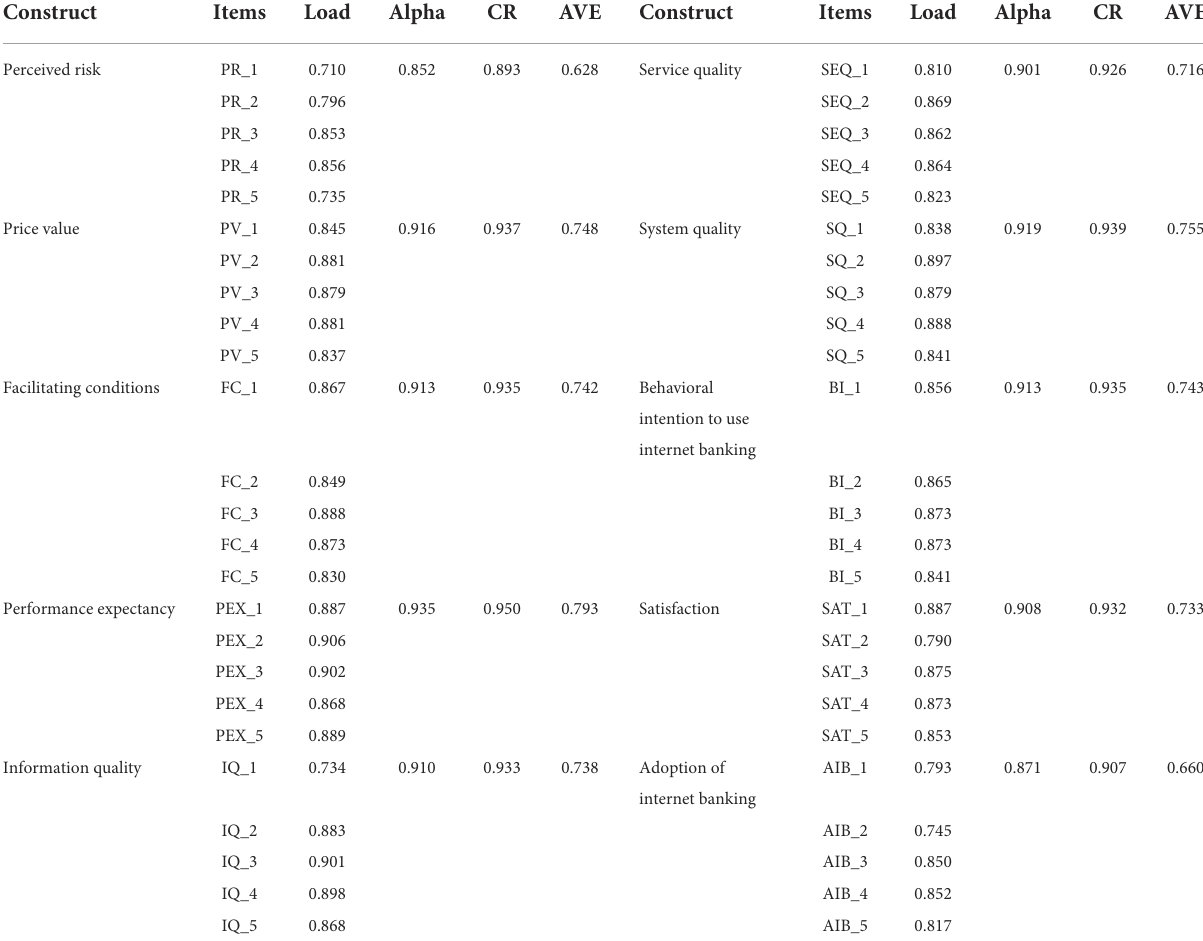
TABLE 2 Reflective indicator loadings, internal consistency reliability, and convergent validity.